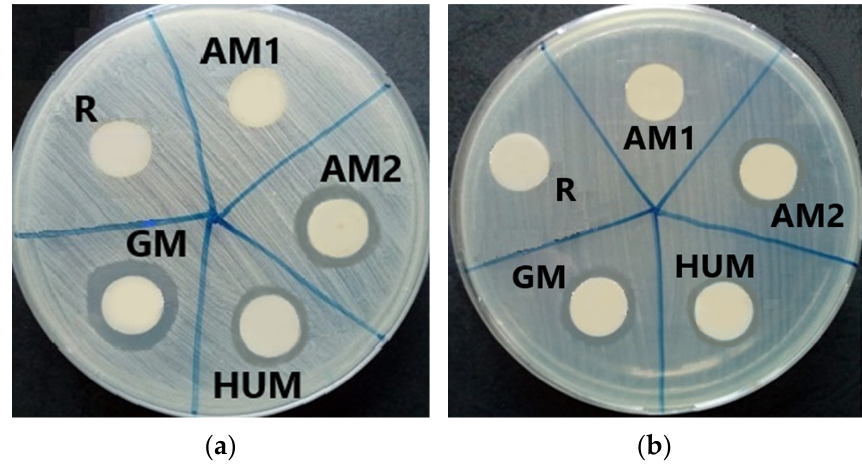
Figure 8. Antibacterial property evaluation for the experimental PMMA bone cements: ( a ) growth inhibition zone for Gram-positive strain Staphylococcus aureus ATCC 2592; ( b ) growth inhibition zone for Gram-negative strain Pseudomonas aeruginosa ATCC 27853, after 72 h of incubation.